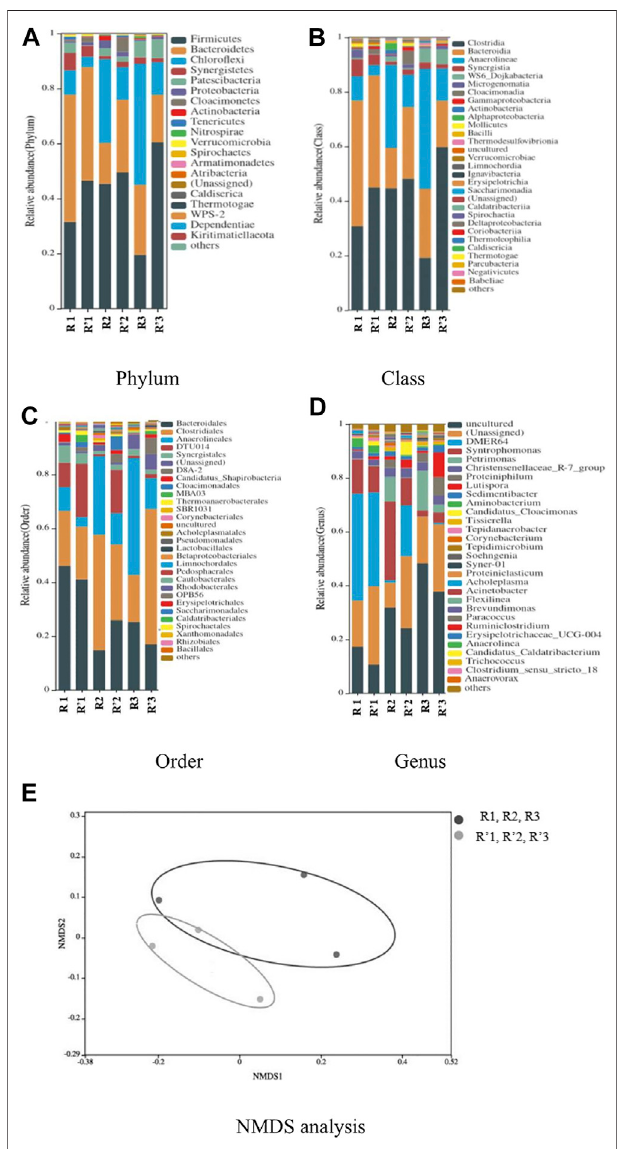
FIGURE 5 | Differences in relative abundance of bacterial communities and species composition of samples at various taxonomic levels. (A – D) The relative abundance of bacterial communities at phylum, class, order, and genus levels, respectively; (E) NMDS analysis.